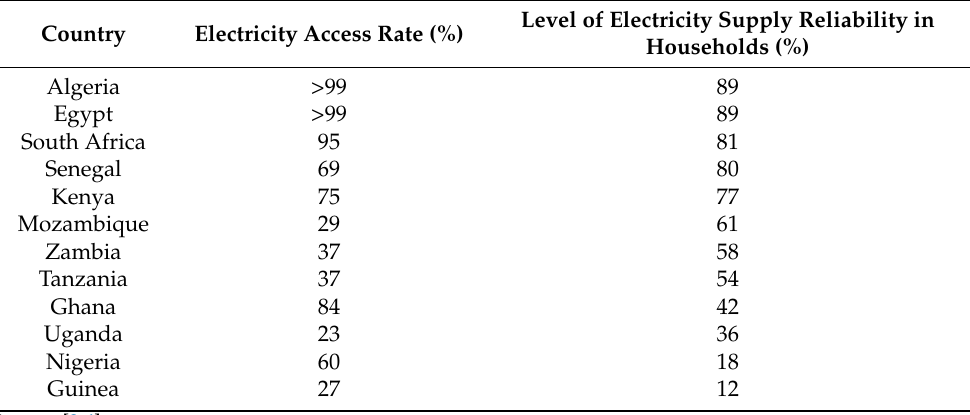
Table 1. Electricity access and reliability rates in select African countries. Country Electricity Access Rate (%)